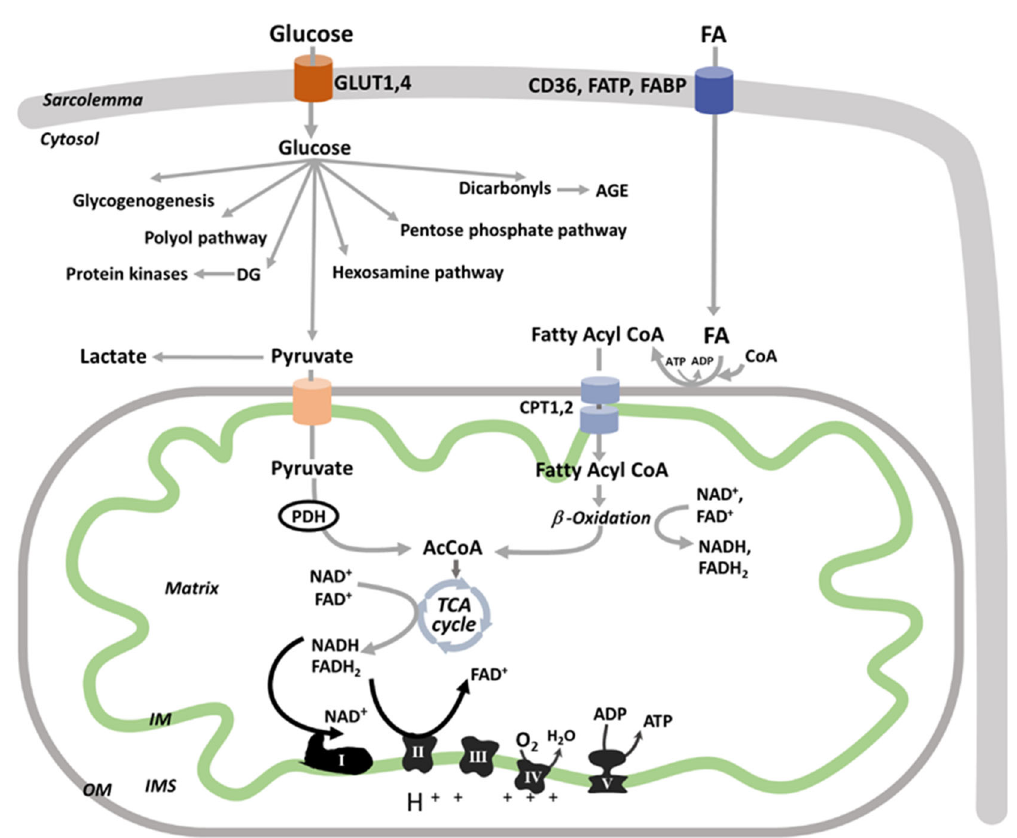
Figure 2. Metabolism of energetic substrates in kidney cells. The basal and insulin ‐ dependent glucose uptake into kidney cells is mediated by the Glucose Transporters (GLUT) 1 and 4. Free fatty acids (FA) enters kidney cells by a route supported by the protein CD36, FA transport proteins (FATPs) [69], and FA binding proteins (FABPs) [70]. FA uptake by kidney cells is not hormonally regulated and driven by their circulating availability. Glucose follows multiple metabolic pathways including glycolysis, glycogen synthesis (glycogenogenesis), polyol pathway (with sorbitol and fructose formation), conversion to either diacylglycerol (DAG) to activate protein kinases or to dicarbonyls (i.e., methylglyoxal) to form advanced glycation end products (AGE), and is shuttled into the hexosamine biosynthetic or pentose phosphate pathways. Pyruvate is either converted to lactate (aerobic glycolysis [71]) or transported into mitochondria via a mitochondrial pyruvate carrier to be converted by pyruvate dehydrogenase (PDH) to acetyl ‐ CoA (AcCoA) for the tricarboxylic acid (TCA) cycle. For simplicity, extramitochondrial glucose fluxes are not shown in detail. After entry into the cell, long chain FAs are activated to FA ‐ CoA that is either esterified as triacylglycerol (stored in the cytosol, not shown) or enter the mitochondria via carnitine palmitoyltransferases (CPT1 and 2) to be oxidized. The end products of each FA β‐ oxidation cycle are NADH, FADH 2 , and acetyl ‐ CoA, which are further oxidized by the electron transport chain (ETC) complexes or TCA, respectively, ultimately leading to ATP synthesis via mitochondrial oxidative phosphorylation. Mitochondrial oxidative phosphorylation is the main ATP provider. While electrons are transferred from the reducing equivalents, NADH and FADH2, to oxygen by the ETC complexes, an electrochemical gradient is built across the mitochondrial inner membrane (IM), which is used by the ATP synthase (complex V) to form ATP. OM: outer membrane; IMS: intermembrane space.